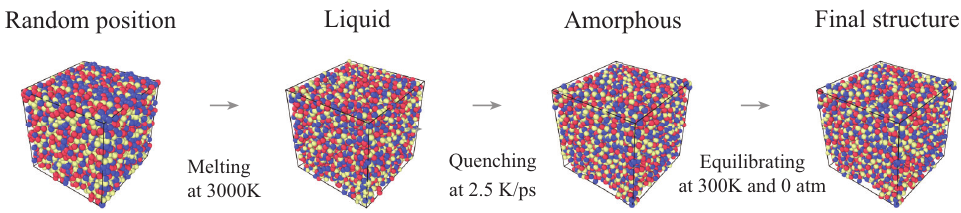
Figure 2. Schematic representation of model construction procedure. (Color scheme—Si: red; C: blue; and N: